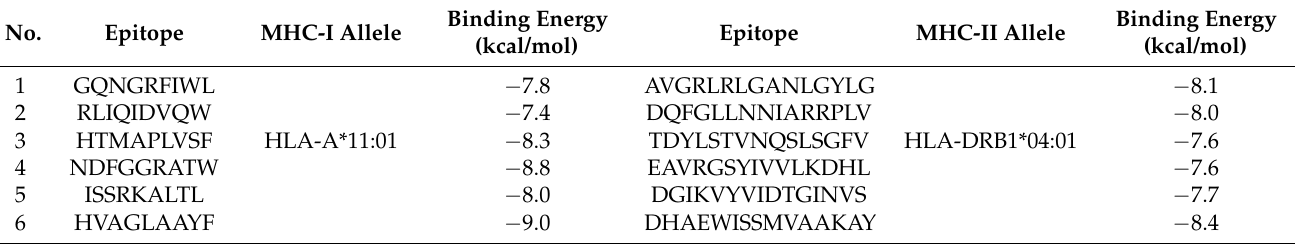
Figure 4. Predicted positions of MHC-II peptides (red color) in the 3D structure of HLA-DRB1*04:01 receptor (blue color), structures ( A – F ) are for epitopes number 1,2,3,4,5 and 6, respectively, from Table 5. Table 5. Selected epitopes’ binding energies with representative MHC-I and MHC-II